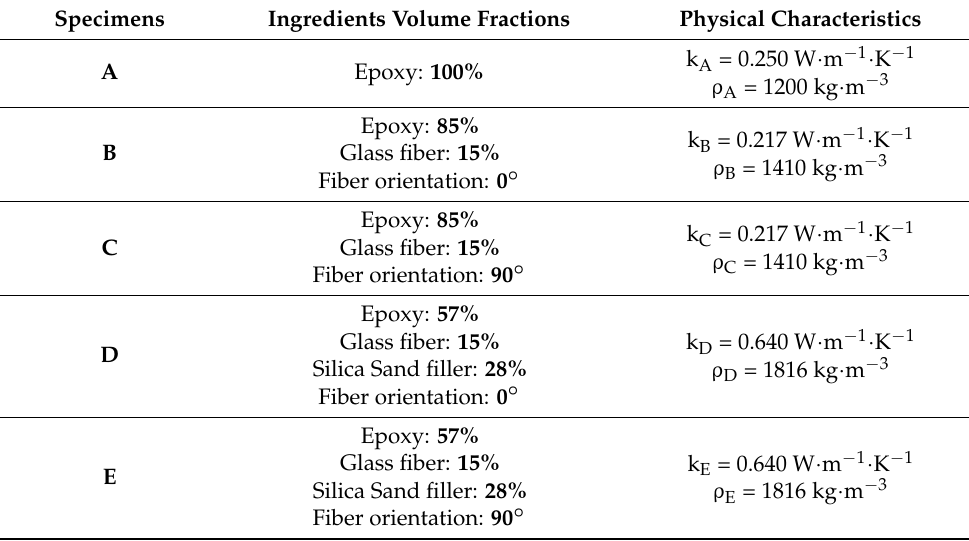
Table 1. Specimens manufacturing configurations and characteristics.